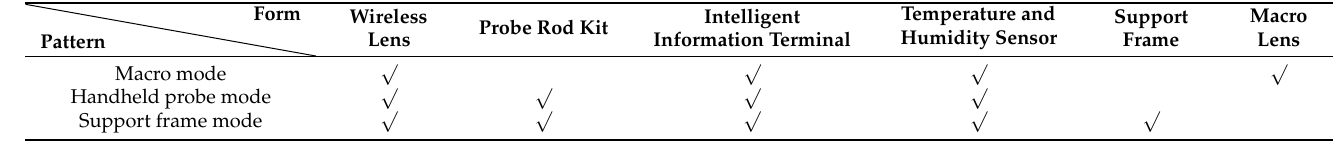
Table 2. Hardware development and composition under different modes.